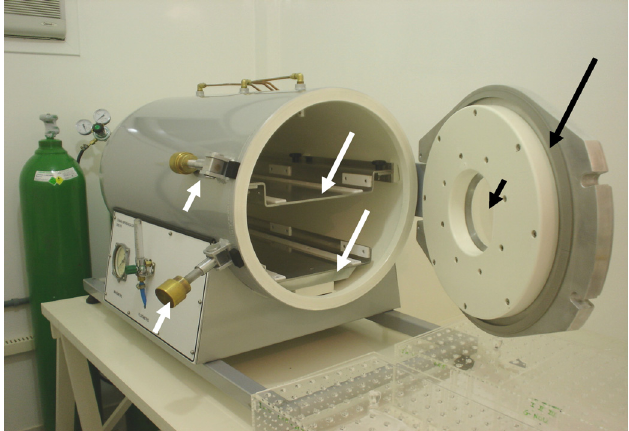
FIGURE 2 - Frontal view of the hyperbaric chamber showing the cover (long black arrow) with acrylic viewfinder (short black arrow), security latches (short white arrows) and internal thick partition up- per/lower walls (long white